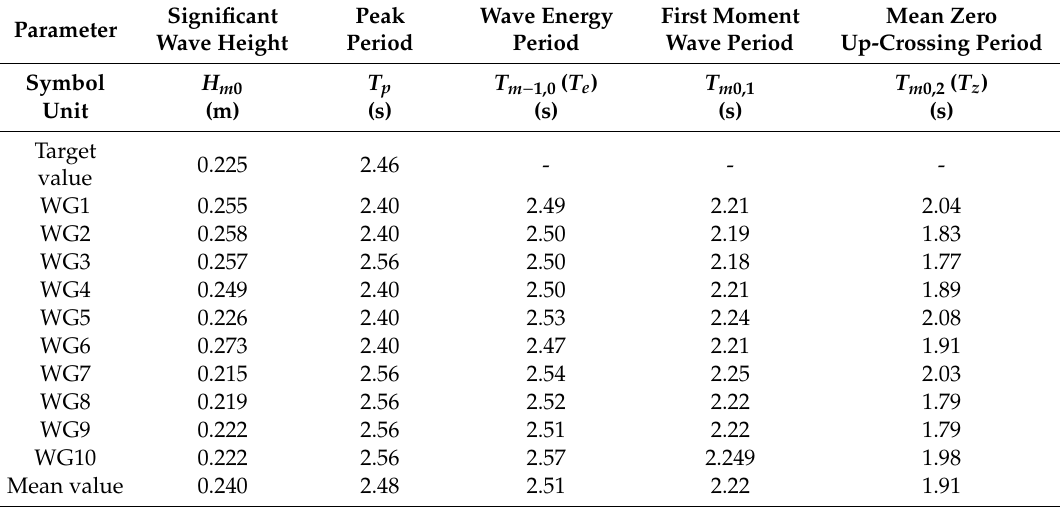
Table 9. Wave characteristics from spectral analysis of the WGs measurements and mean values for Test 04_B. Significant Wave Energy First Moment Mean Zero Up- Parameter Peak Period Period Wave Period Crossing Period